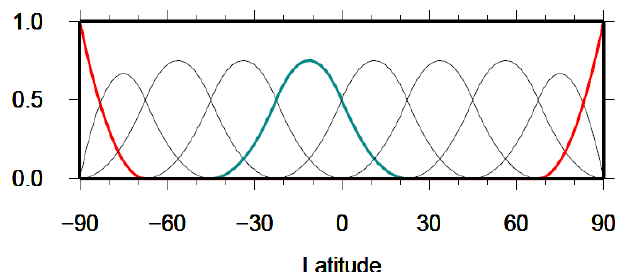
Figure 2. Polynomial B-splines of level J 1 = 3 with a total number = 2 3 + 2 = 10 of B-splines along the meridian. The blue spline K J 1 (ϕ) corresponds to the shift value k 1 = 4 and covers function N 2 3 , 4 a subinterval of length (cid:49) 3 ≈ 3 · 180 ◦ / 9 = 60 ◦ . The red spline func- (ϕ) with shift value k 1 = 0 and N 2 tions N 2 3 , 0 k 1 = 9 close the modeling interval at the